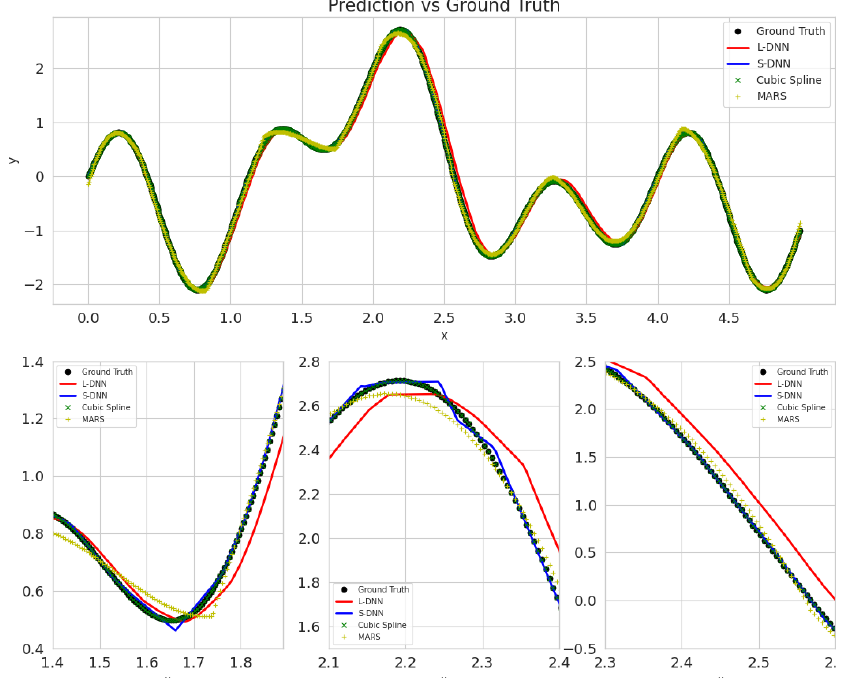
Figure A2. Predictions’ of all tested methods on the test set for noise = 0%, trained on 900 samples. Blue represents SDNN, red LDNN, green cubic splines, and yellow